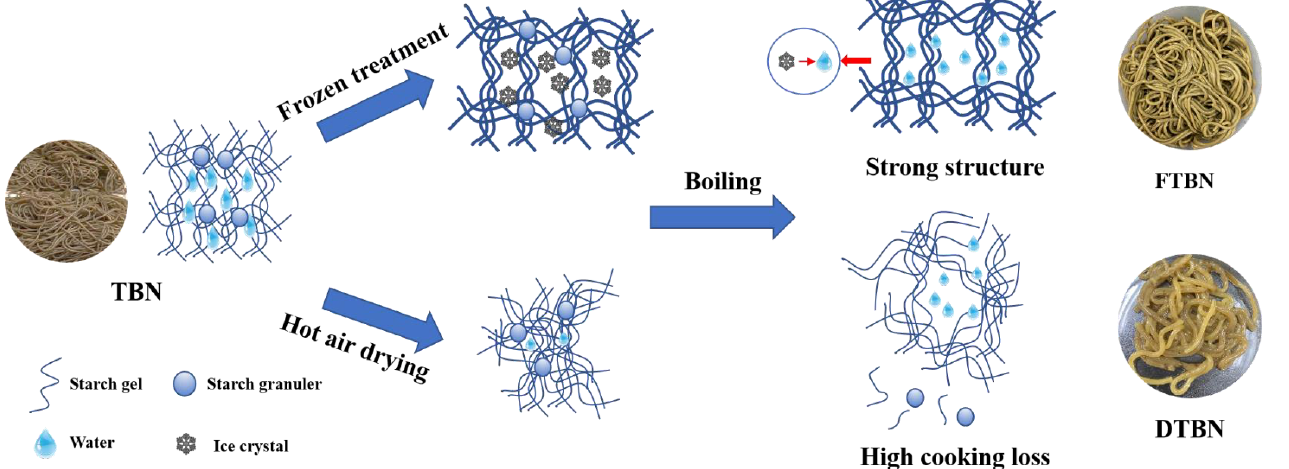
Figure 6. Schematic diagram on the quality of maintenance by frozen treatment and deterioration by hot air drying extruded noodles. TBN, fresh Tartary buckwheat noodles; DTBN, dried Tartary buckwheat noodles; FTBN, frozen Tartary buckwheat noodles.